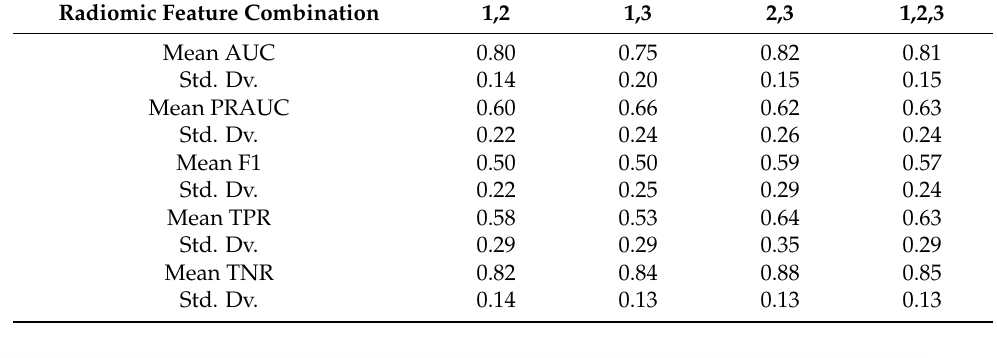
Table 3. ROC analysis results for testing the combination of any two or all three top radiomic features selected from 3000 (1000 repeats of 3-fold cross-validations) tests. The best-performing model based on the mean AUC value was the combination of features 2 and 3. AUC: Area under ROC curve; Std. Dv.: standard deviation; PRAUC: area under the precision-recall ROC curve; TPR: true positive